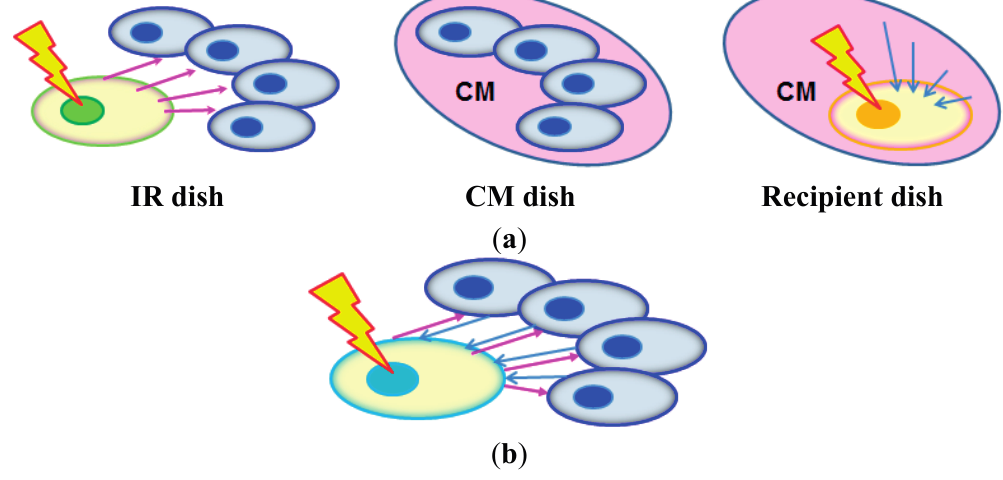
Figure 5. ( a ) Special procedures to study the rescue effect by physically separating the rescue signals (represented by blue arrows) from the bystander signals (represented by pink arrows) through the preparation of the CM (pink). The irradiated cell (green) sending out the bystander signals was different from the irradiated cell (orange) receiving the rescue signals. Preparation and use of the CM involved three separate dishes. The first was the “IR dish” to hold the cells for alpha-particle irradiation with partnered unirradiated cells to allow co-culture. The second was the “CM dish” to hold the unirradiated cells transferred from the IR dish to create the CM. The third was the “Recipient dish” to hold the HeLa cells for alpha-particle irradiation, which were immersed in the CM harvested from the CM dish; ( b ) Setup to study the rescue effect without physically separating the rescue signals from the bystander signals. The irradiated cell (cyan) receiving the rescue signals was the same as the irradiated cell sending out the bystander